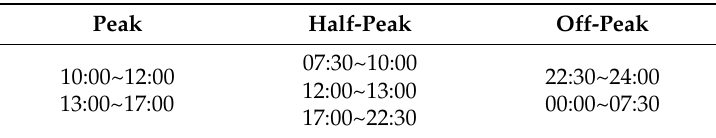
Table 1. Time intervals of applicable rate